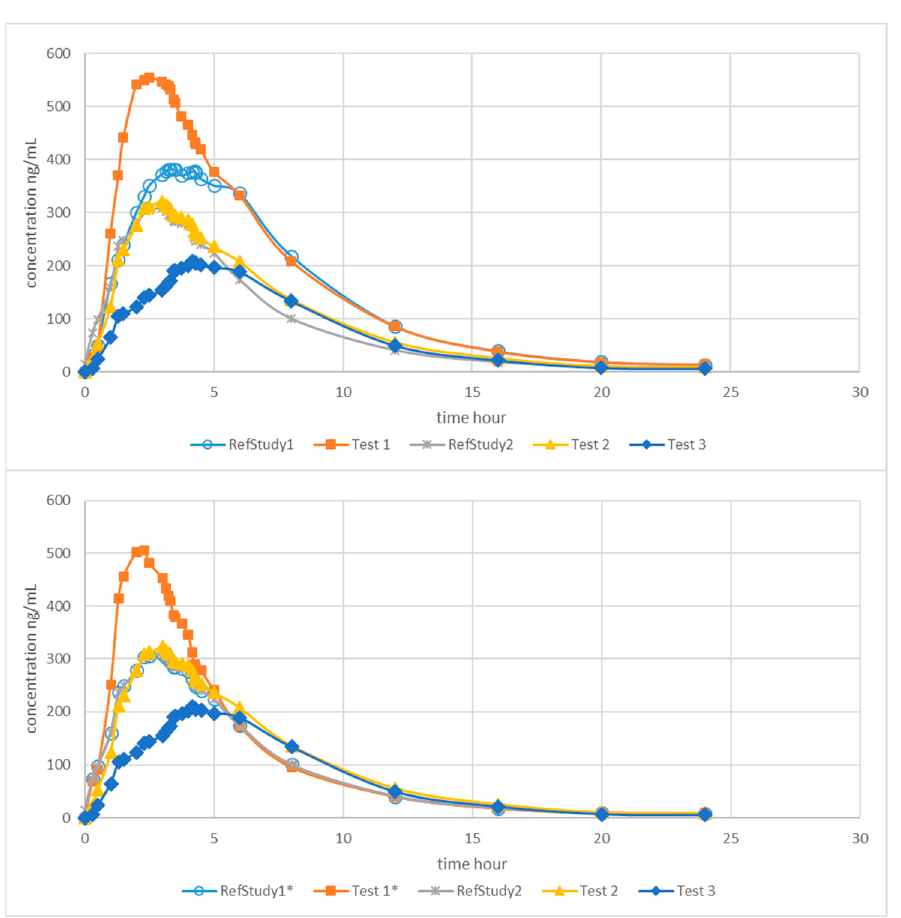
Figure 1. Original ( top panel ) and * normalized ( bottom panel ) montelukast plasma concentrations.